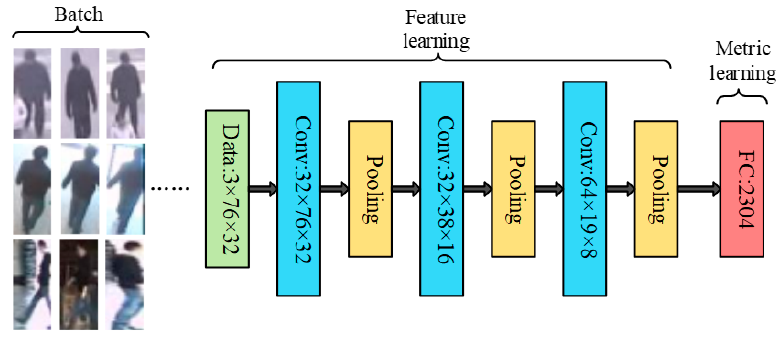
Figure 1. The structure of NCA-net.